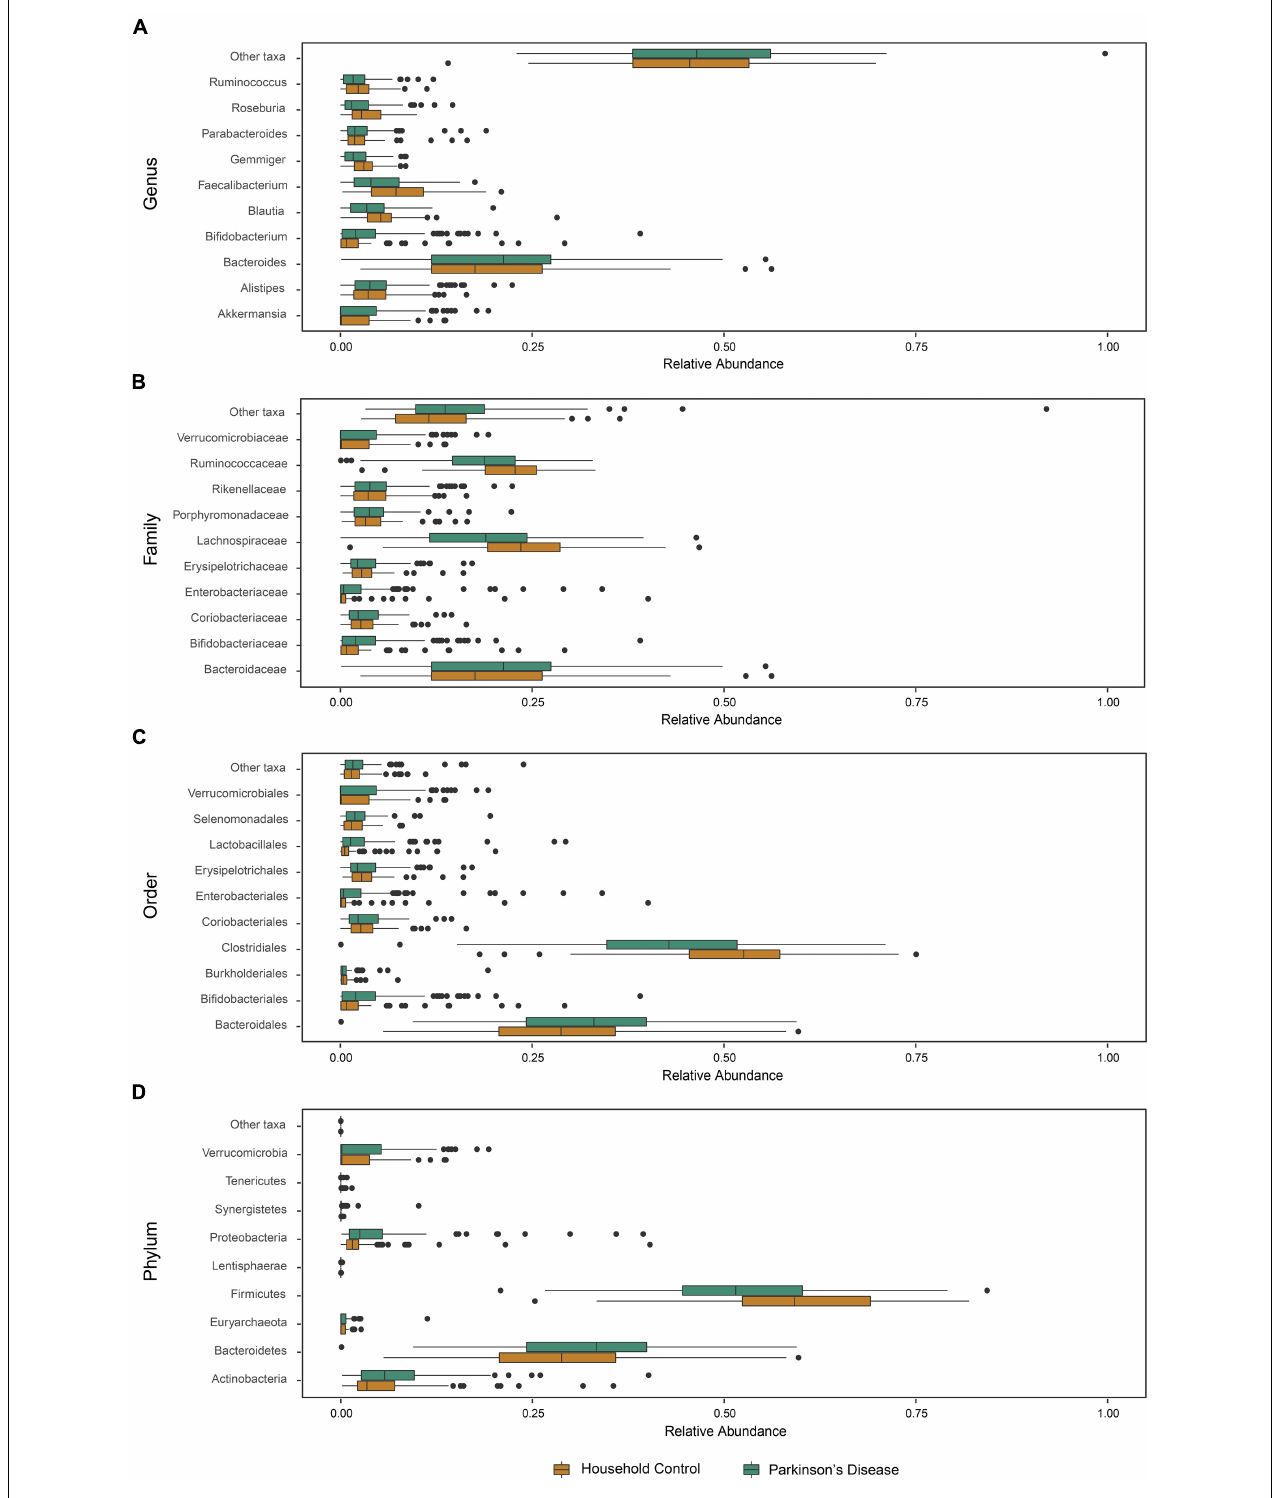
FIGURE 2 | Microbiota abundance for household control (HC) and Parkinson’s disease (PD) groups. The relative abundance of phylogenetic gut microbiome taxa composition at the (A) genus, (B) family, (C) order, and (D) phylum level for individual participants ( n = 81 HCs and n = 103 PD) showed a statistically significant compositional difference between PD and HC groups at each studied taxonomic level (PERMANOVA, p < 0.01 genus, p < 0.01 family, p < 0.01 order, p = 0.02 phylum).